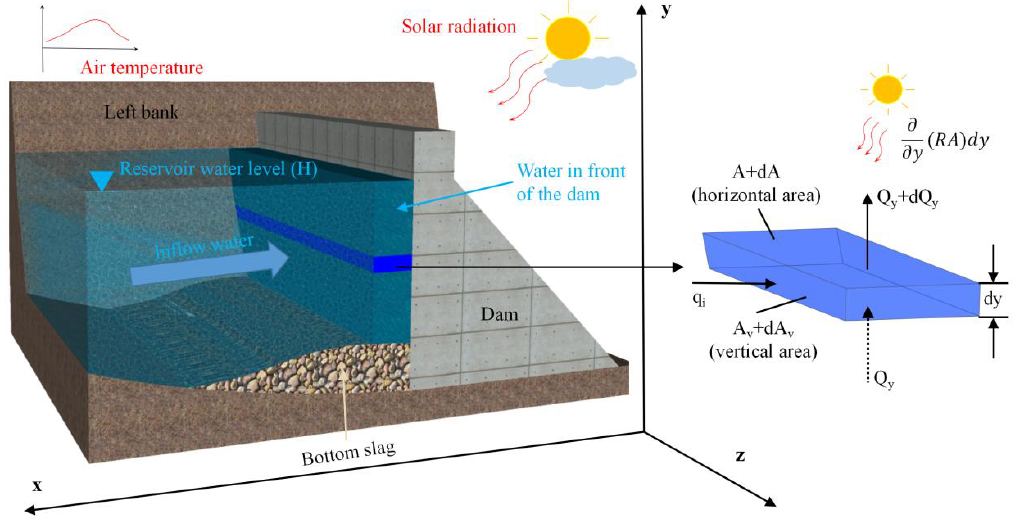
Figure 1. Schematic diagram of the simulation model.